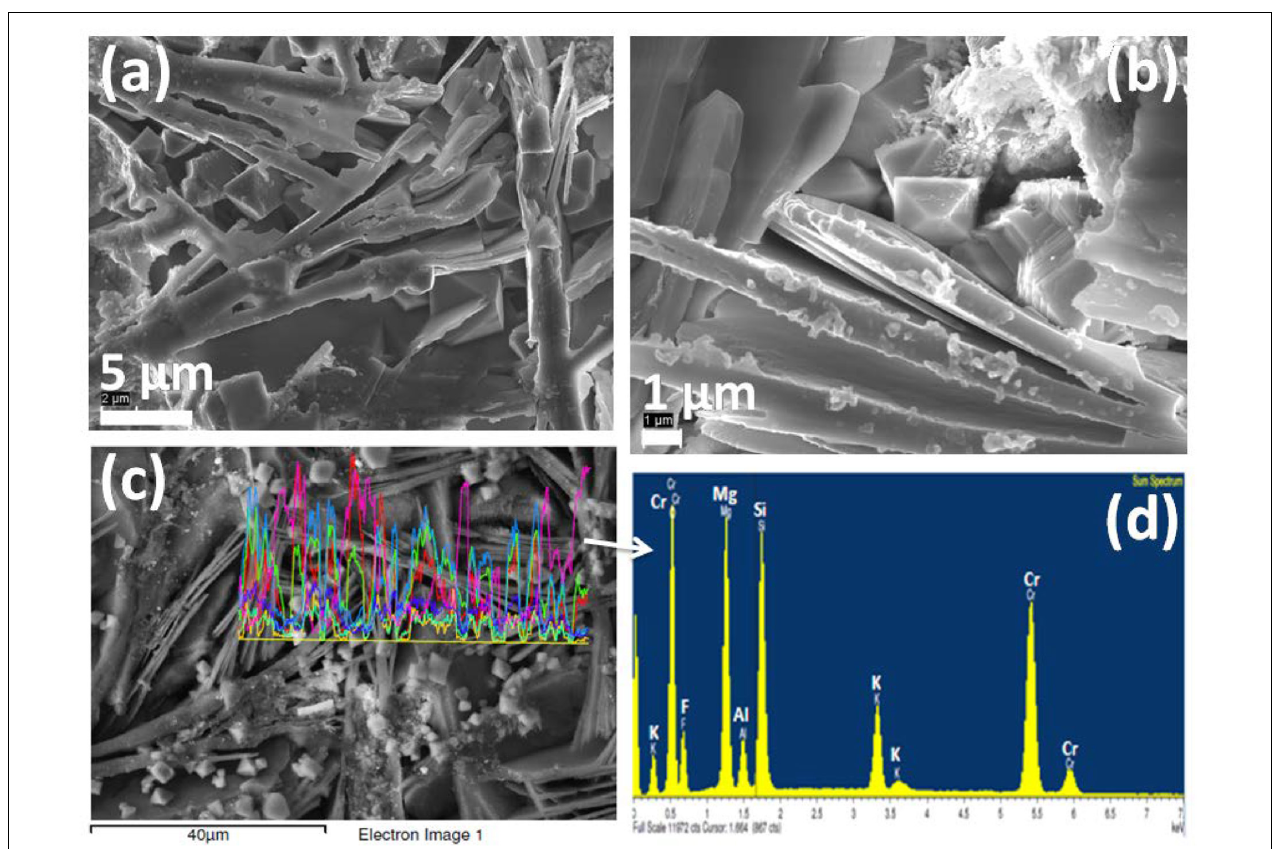
FIGURE 7 | (a,b) FESEM photomicrographs (in 5 and 1 µ m) and (c,d) EDX pattern of K 2 O-MgO-Al 2 O 3 -B 2 O 3 -SiO 2 -F glass containing 4 mol% K 2 Cr 2 O 7 content, Cr-4; showing the dispersed crystalline phases (MgCr 2 O 4 , MgF 2 , K 3 CrF 6 and